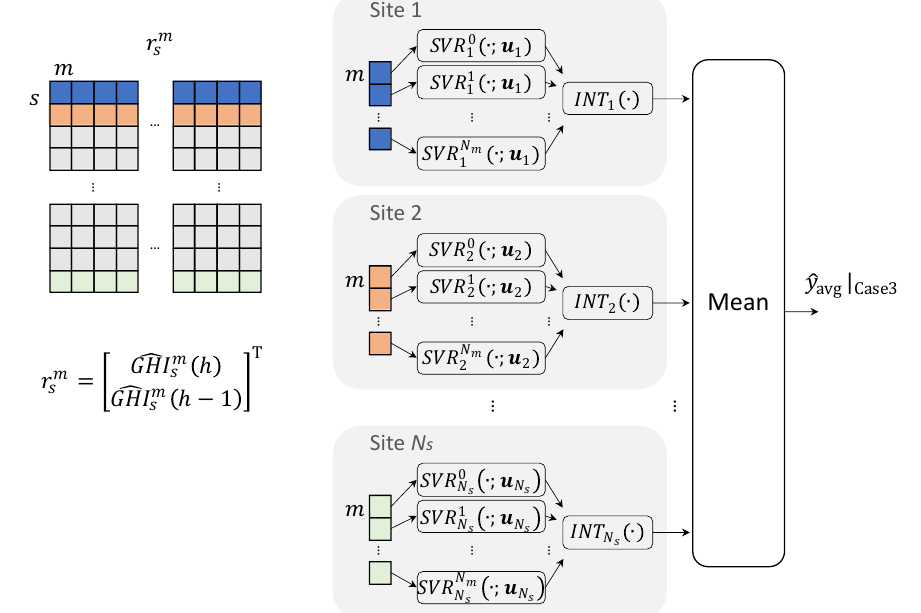
Figure 5. Schematic of the access of the MEPS’s GHI forecasts in Case3. This prediction model places the integrators ( INT s ( • ) , s = 1,2, . . . ,5) at each site. Weak learners ( SVR m s ( • , u s ) ) output the prediction, and then they are gathered into the integrators at ensemble nodes. Each ensemble node forecasts the local GHI. Then, regional GHI is obtained from the mean function. Integrators use mean function or SVR in Case3a and